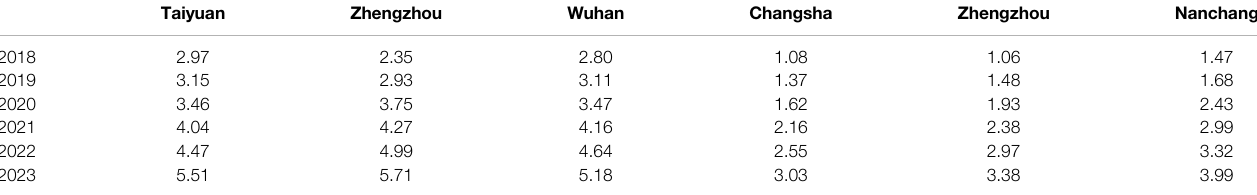
TABLE 8 | Projected trends in urban household gas consumption in the Central Region.